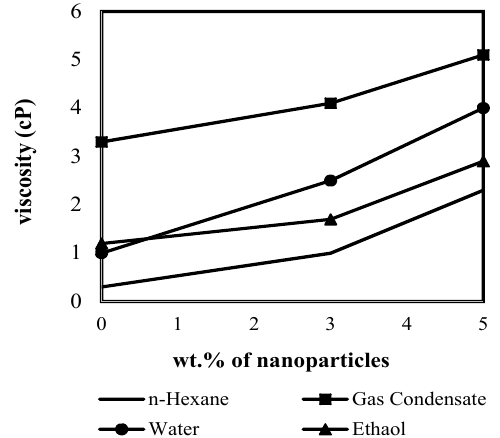
Fig. 5. Change in viscosity versus wt.% of silica nanoparticle in different base